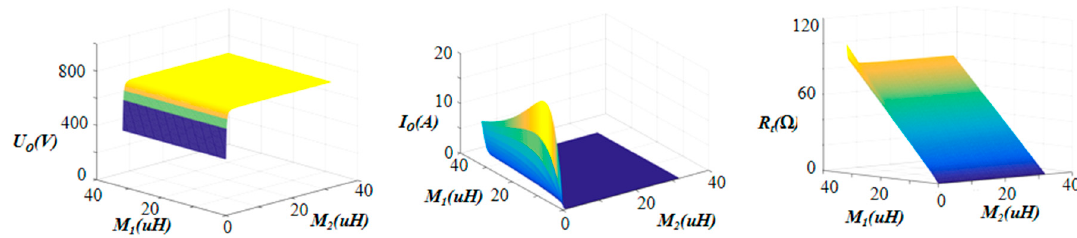
Figure 19. Contour map of system parameters ( U O , I O , R t and M 1 , M 2 ).